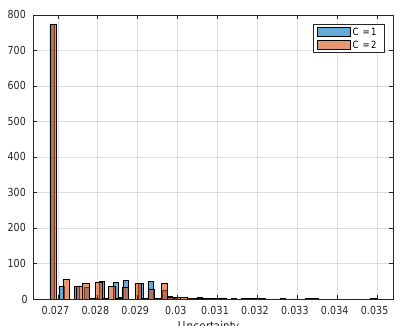
Figure A21. Histograms for the conclusion of the effect of factor C on the expected uncertainty performance when B = 2, represented for the two levels of factor C.